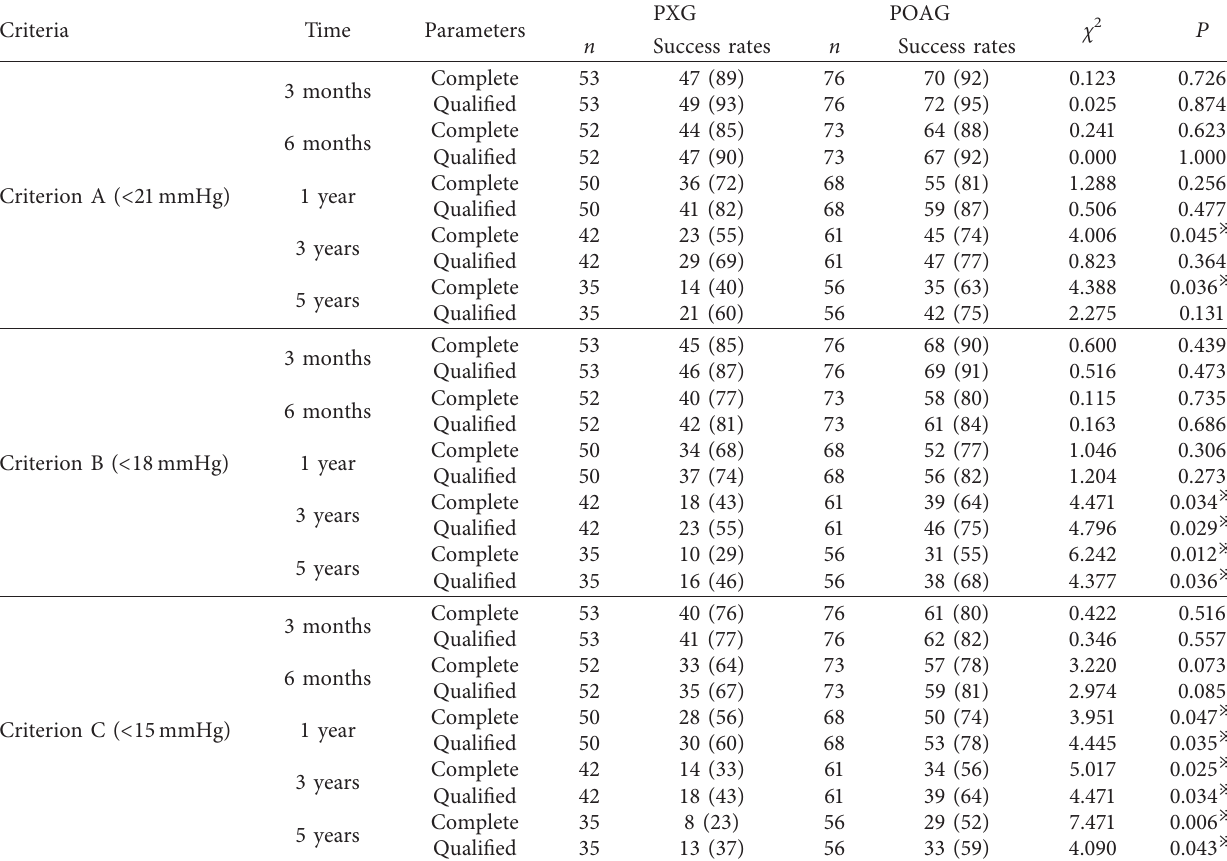
Table 3: Comparison of surgical success rates between the two groups n (%).